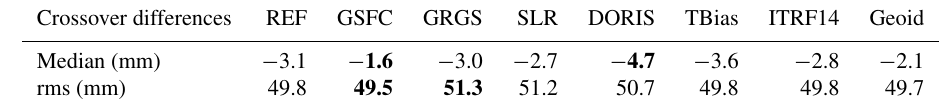
Table 3. Crossover point analysis: median and rms values of global mean height differences for maximum time lapses of 5 days for all orbit solutions during the period April 1993–September 2004. The highest and lowest values of each quantity are marked in bold.